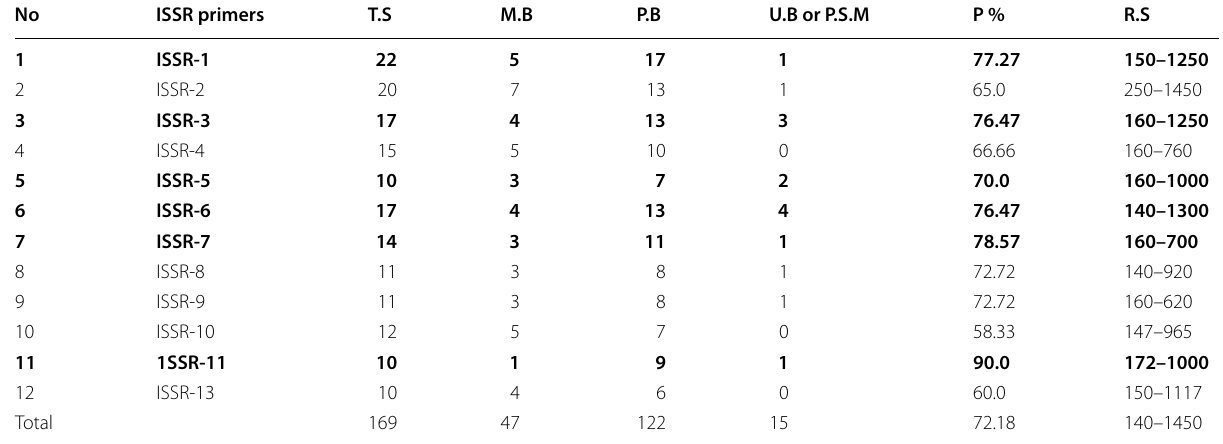
Bold values are very important values that are used in the case of important comparisons in the results and discussion